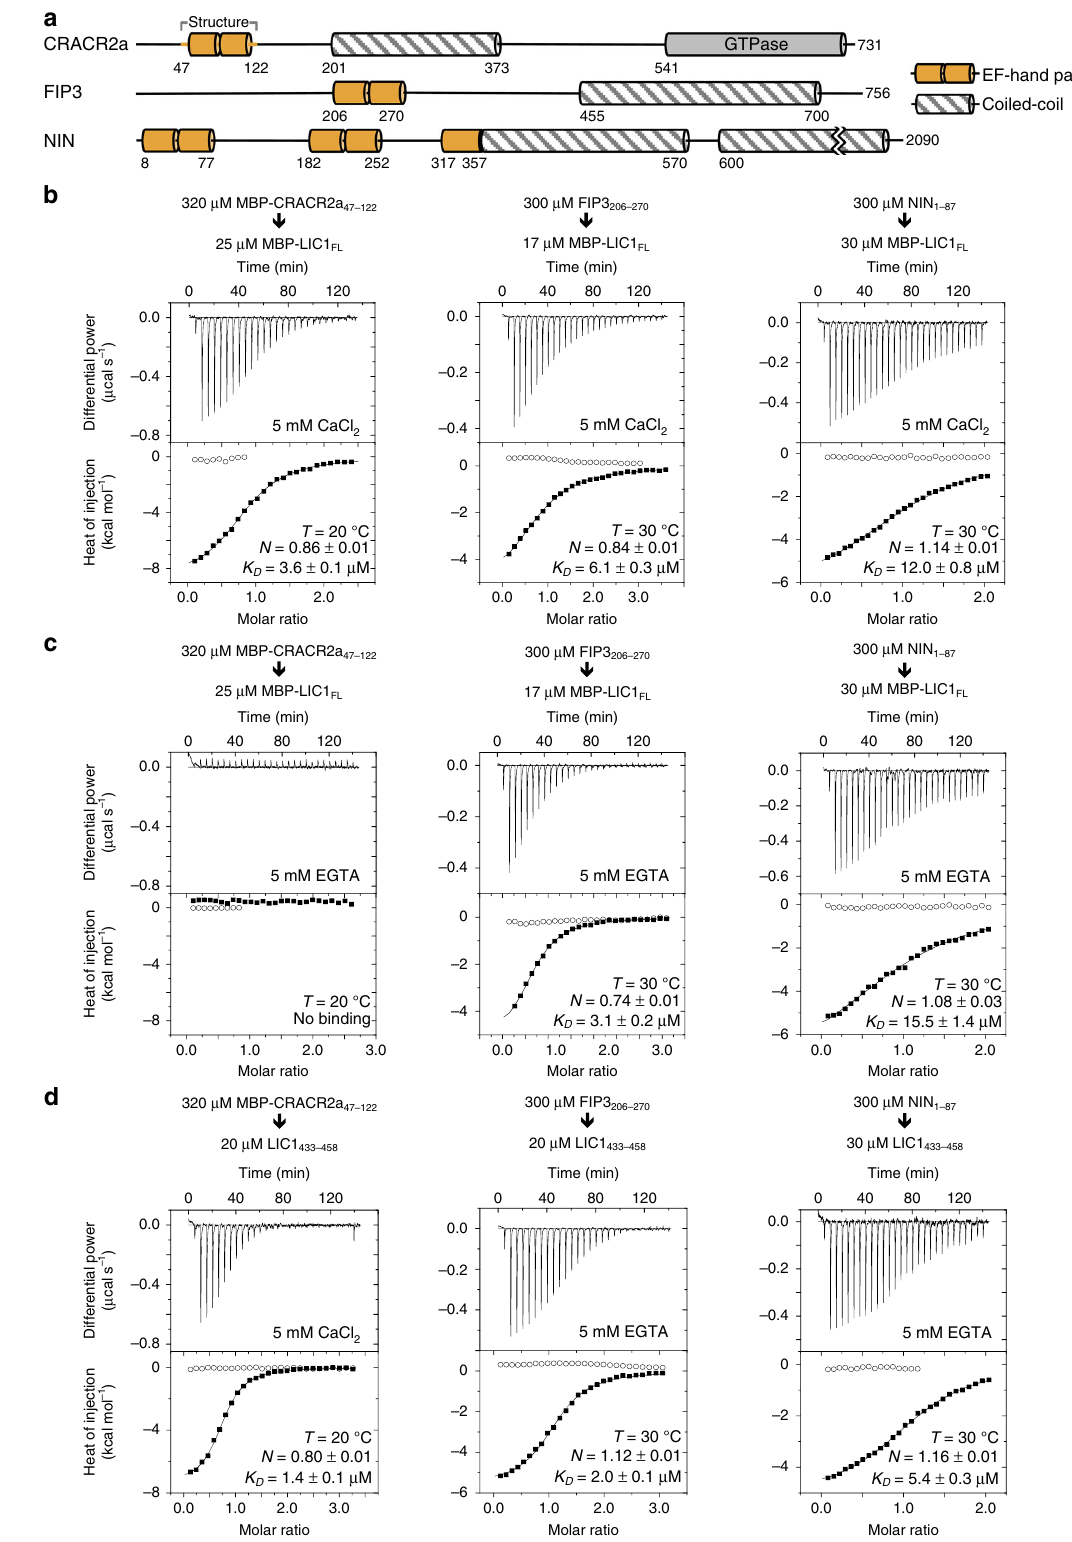
Fig. 2 LIC1 interaction with EF-hand-containing dynein – dynactin adaptors. a Domain organization of EF-hand-containing adaptors, highlighting the EF- hand pair of CRACR2a that was co-crystallized with LIC1 433 – 458 . b – d ITC titrations of EF-hand pairs from human CRACR2a, FIP3 and NIN into MBP-LIC1 FL or LIC1 433 – 458 and in the presence of 5 mM CaCl 2 or 5 mM EGTA (as indicated). ITC data shown are representative of n = 2 independent experiments, with similar results. Listed for each titration are the experimental conditions and fi tting parameters, including the dissociation constant ( K D ) and binding stoichiometry ( N ) derived from fi tting to a binding isotherm (black line). The K D and N values are given as mean ± s.d. of the fi ts. Open symbols correspond to a control titration into